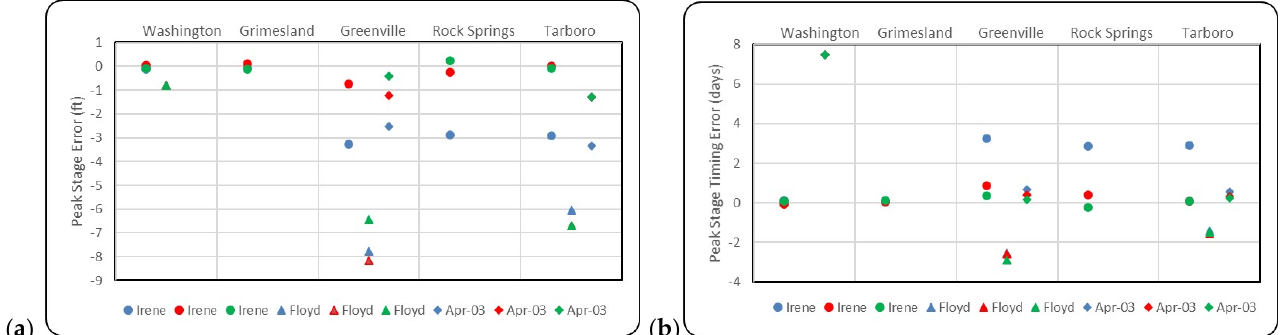
Figure 8. Stage errors along the Tar River for peak ( a ) magnitude and ( b ) timing during all events (data not available at all locations). Shapes indicate which event is being analyzed, and green colors indicate results from the ASGS-storm system, red from the sequential HEC-RAS coupling, and blue from the middleware coupling scheme.